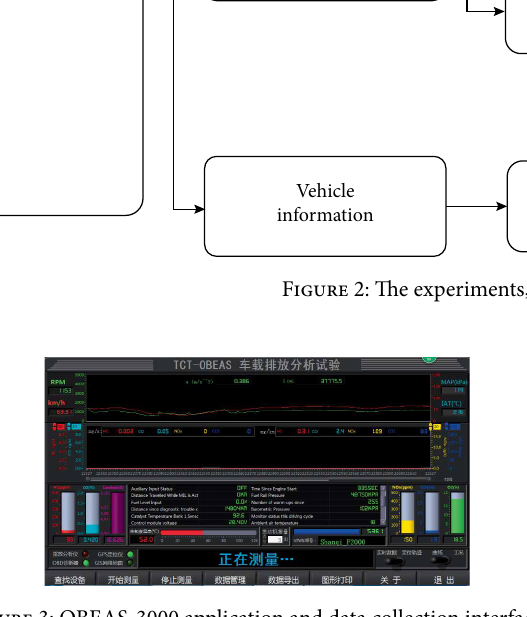
Figure 3: OBEAS-3000 application and data collection